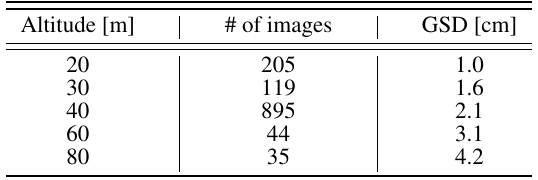
Table 2. Number of collected images and Ground